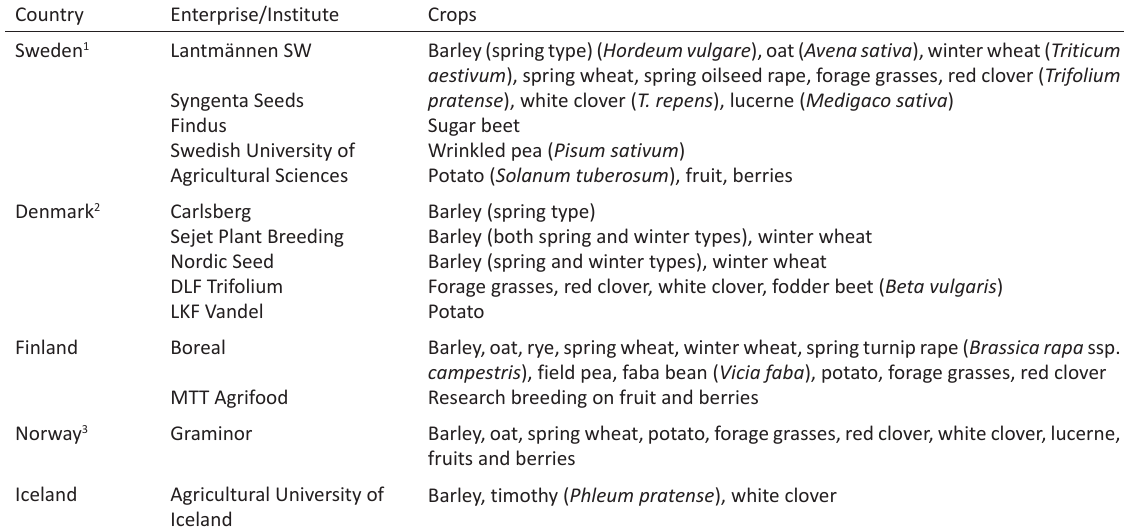
Table 1. Overview of plant breeding for food and agriculture in Sweden, Denmark, Finland, Norway and Iceland in 2014 (only breeding programmes carried out in the Nordic area are included, micro-companies do exist and are listed in the footnote)